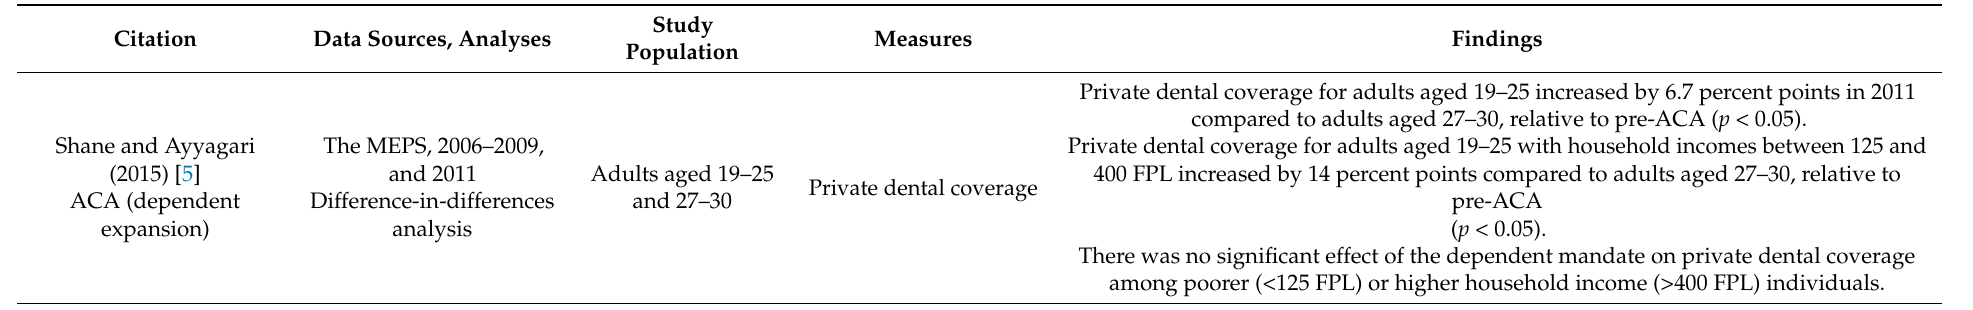
Table 2. Findings from Studies of effects of Affordable Care